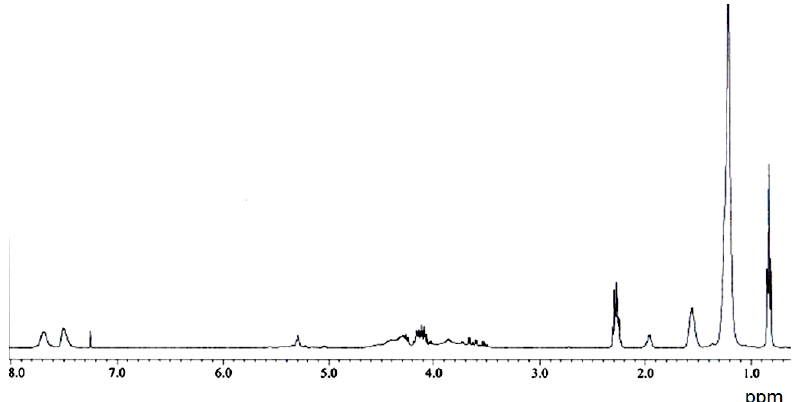
Figure 7. Infrared spectra of: ( a ) Neat alkyd; ( b ) Extracted core; and ( c ) PMUF shell.